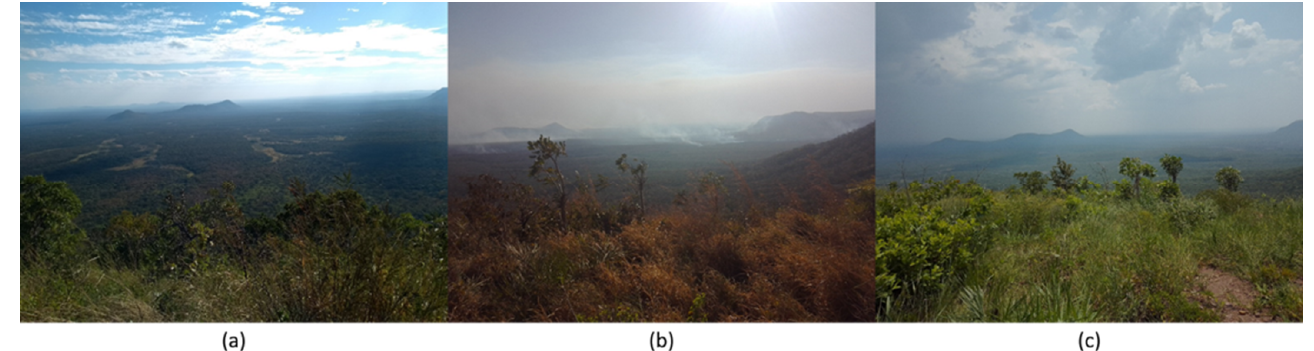
Figure 3. Landscape view of the Kadiwéu Indigenous Reserve at the beginning of the dry season in June 2021 ( a ), the end of the dry season in August 2021 ( b ), with several fire foci visible in the background, and at the beginning of the wet season in February 2021 ( c ).